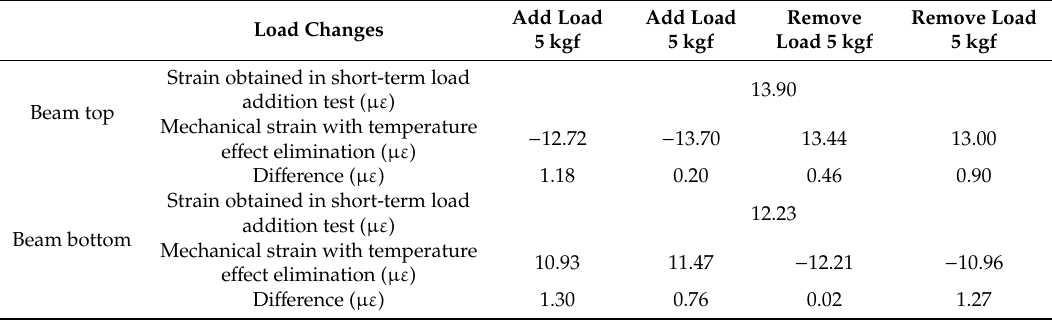
Table 3. Test error for mechanical strain with temperature e ff ects eliminated.